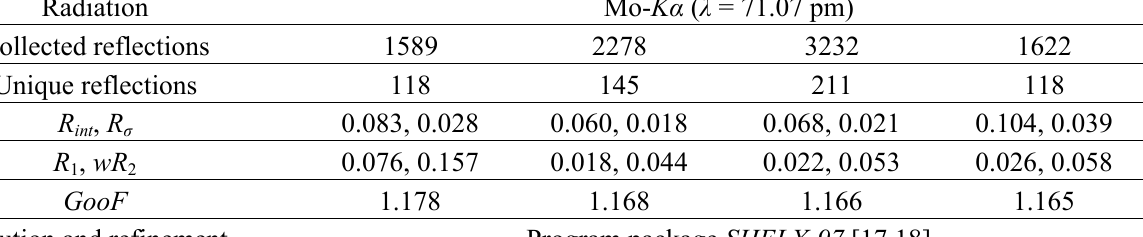
Table 1. Crystallographic data for selected crystals of Ca